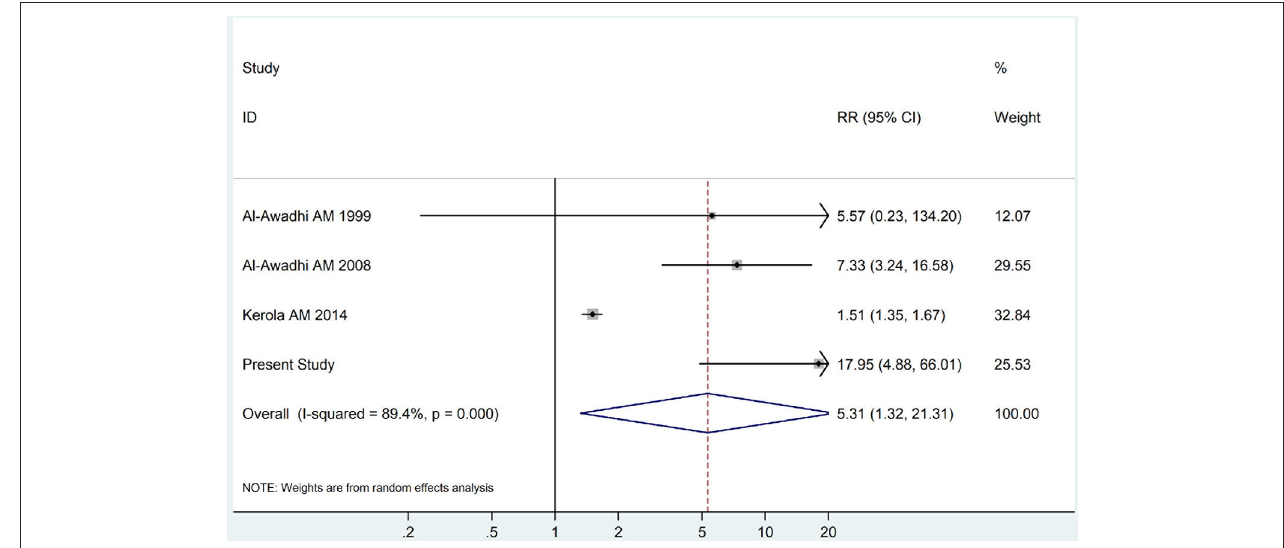
FIGURE 5 | Forest plot for the increased risk of overt hypothyroidism among RA patients (The diamond represents the pooled RR and 95% CI).